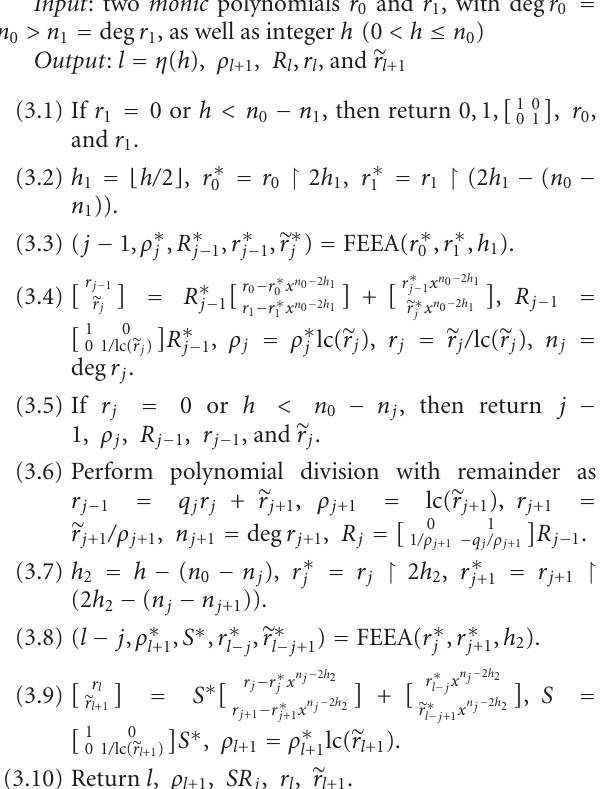
Algorithm 3. (modified fast extended Euclidean